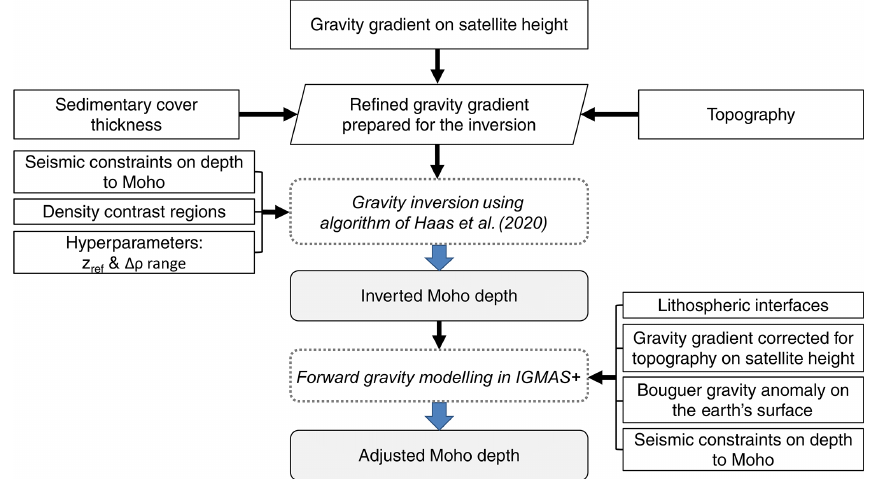
Figure 2. Schematic workflow of the study. The initial step is to prepare the gravity data for the inversion by subtracting the sedimentary cover effect from the topographically corrected vertical gravity gradient. Then it can be followed by a subsequent gravity inversion with laterally variable crust–mantle density contrast (Haas et al., 2020). The inverted Moho depth is incorporated along with other lithospheric interfaces as well as seismic and gravity constraints in IGMAS + software (Schmidt et al., 2020; Götze and Lahmeyer, 1988). The interfaces are modified to fit the existing gravity and seismic constraints providing the adjusted Moho depth of the region. Table 1. Summary of datasets used in the